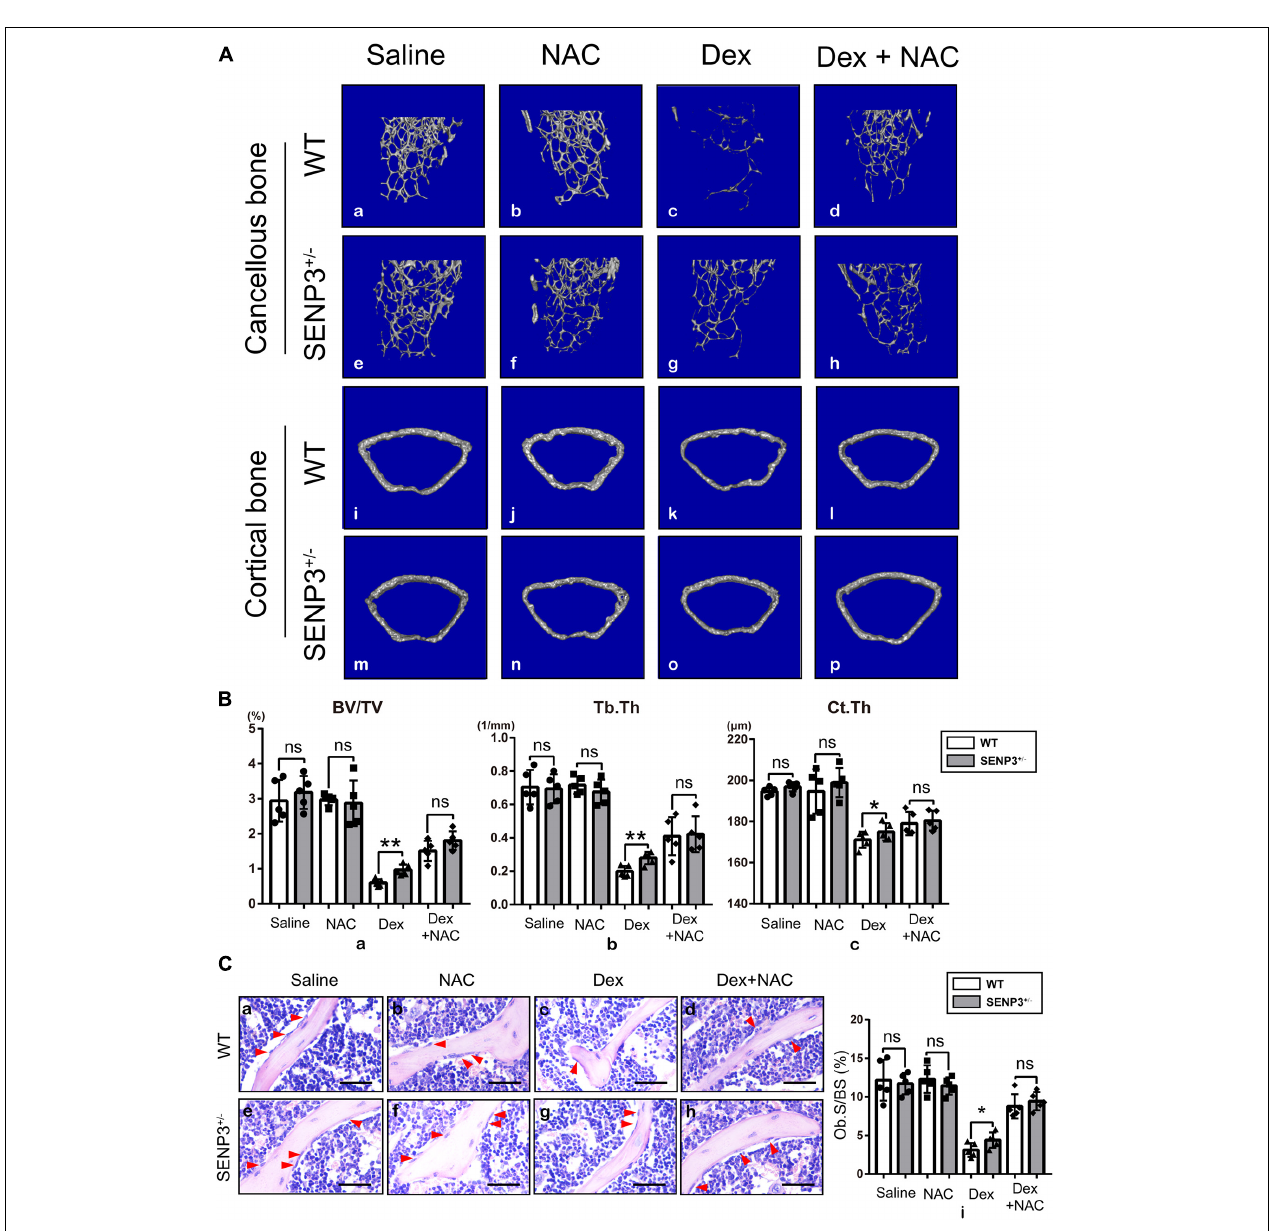
FIGURE 5 | SENP + / − mice were less likely to suffer severe GIOP probably with undisturbed osteogenesis by Dex-induced ROS upregulation. (A) Represented images of three-dimensional (3D) cancellous bone restoration (a–h) of the distal femur cancellous bone in 8–12 week-old WT and SENP3 + / − mice with saline ( n = 5, a,e ), NAC alone ( n = 5, b,f ), Dex alone ( n = 5, c,g ) and Dex + NAC ( n = 5, d,h ), and three-dimensional (3D) cortical bone restoration (i–p) of the distal femur cortical bone in 8–12-week-old WT and SENP3 + / − mice with saline ( n = 5, a,e ), NAC alone ( n = 5, b,f ), Dex alone ( n = 5, c,g ) and Dex + NAC ( n = 5, d,h ); (B) Trabecular bone volume/tissue volume ratios (%) (BV/TV, a ), trabecular thickness (Tb.Th, b ) and cortical thickness (Ct.Th, c ) the distal femur cancellous and cortical bone in 8–12-week-old WT and SENP3 + / − mice with saline ( n = 5), NAC alone ( n = 5), Dex alone ( n = 5), and Dex + NAC ( n = 5). (C) HE staining (a–h) of distal femur on paraffin-embedded bone sections in in 8–12-week-old WT and SENP3 + / − mice with saline, NAC alone, Dex alone and Dex + NAC (scale bar, 100 mm; red arrow heads point to osteoblasts); osteoblast surface/bone surface ratios (Ob.S/BS) (i) is shown on the right. Data are shown as the mean ± SEM. * p < 0.05, ** p < 0.01, ns: not significant. All the data were obtained from at least three independent experiments.